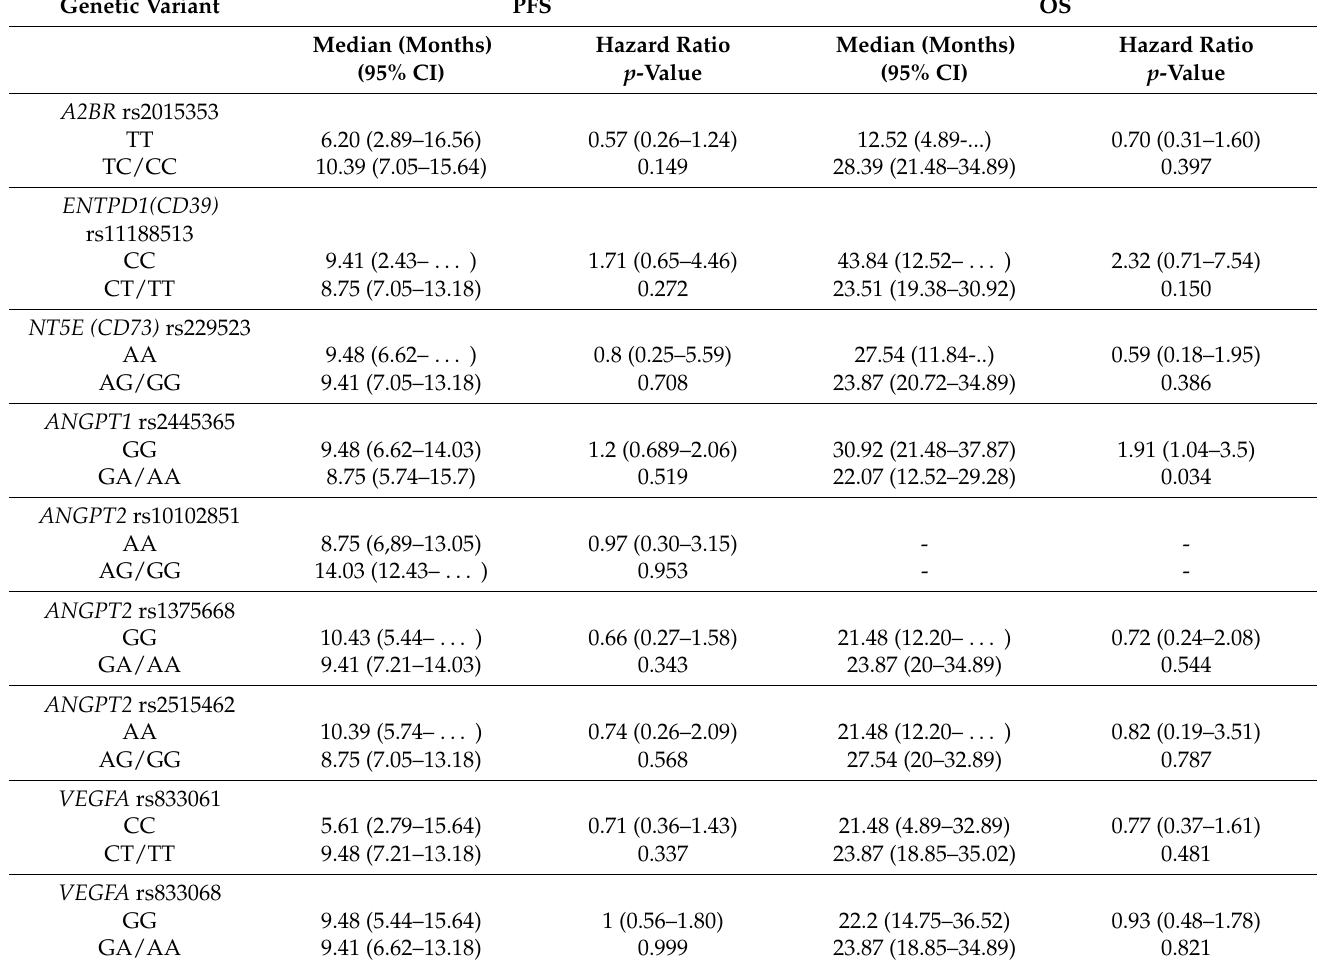
Table 4. Analysis of polymorphisms according to progression-free survival (PFS) and overall survival (OS). Genetic